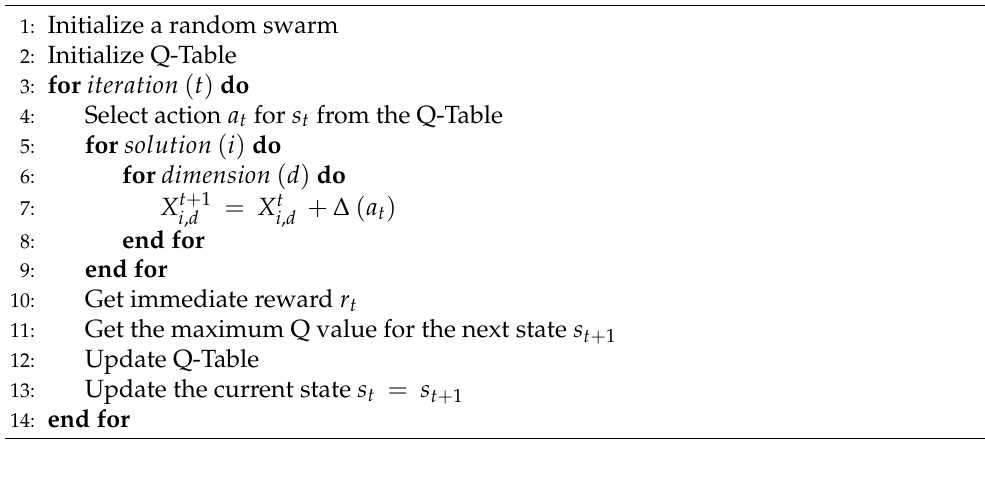
Algorithm 1 Data-driven dynamic discretization framework